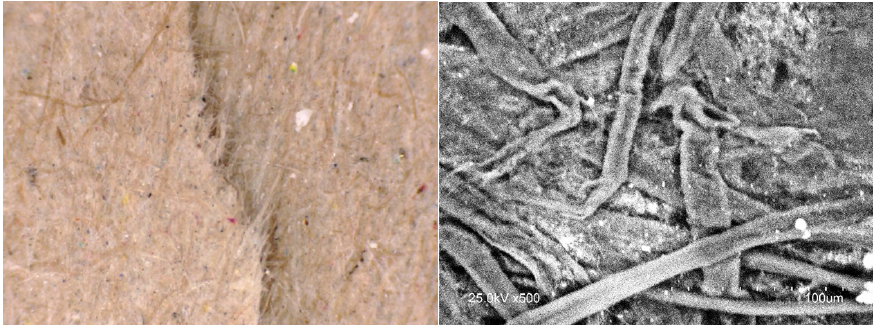
Figure 1. Optical ( left ) and SE ( right ) microscopic images of the corrugated paperboard middle component paper layer